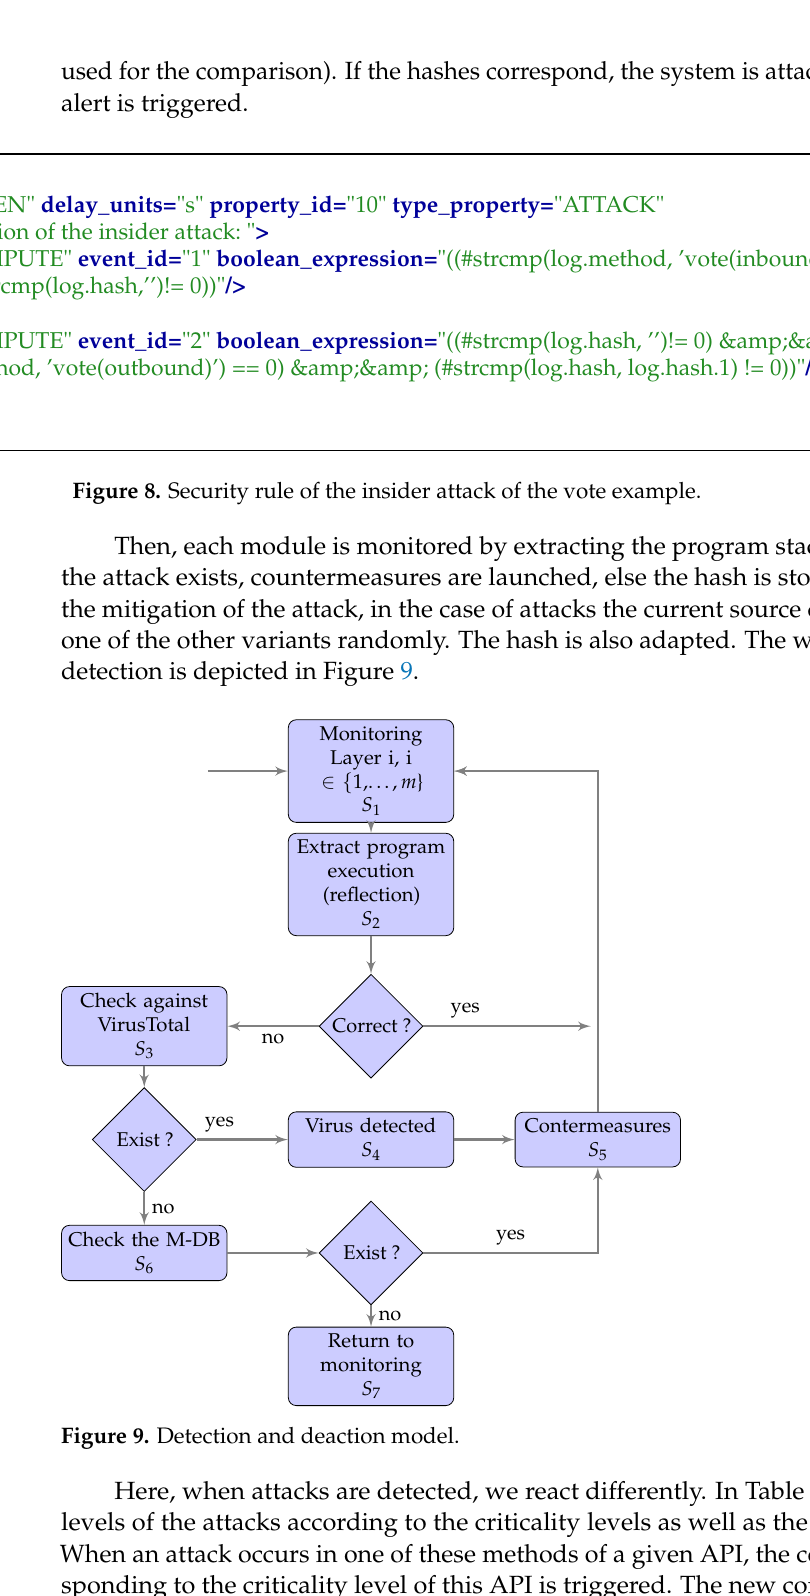
Figure 9. Detection and deaction